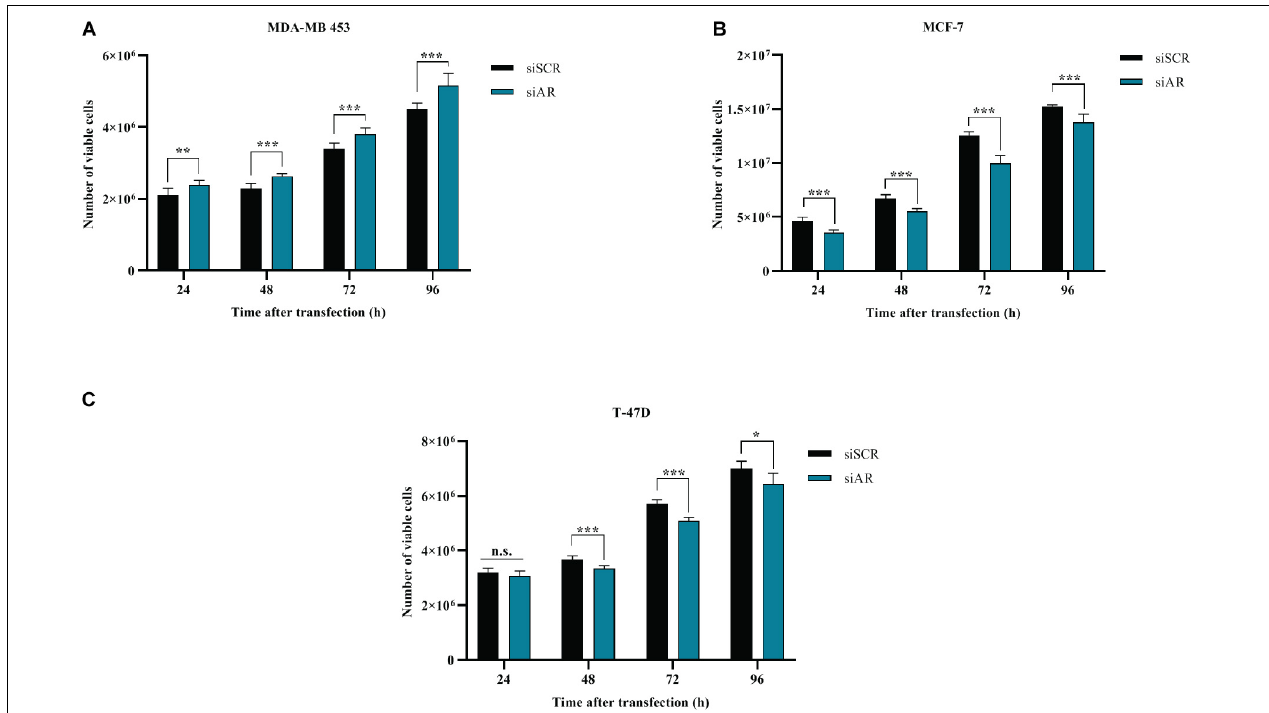
FIGURE 4 | Effects of AR silencing (siAR) on proliferation of BC cell lines (A) MDA-MB-453 (B) MCF-7 (C) T-47D. * p < 0.05, ** p < 0.01, *** p < 0.001, n.s., not significant. Multiple t -test, corrected for multiple comparison using the Holm-Sidak method in (A–C) .